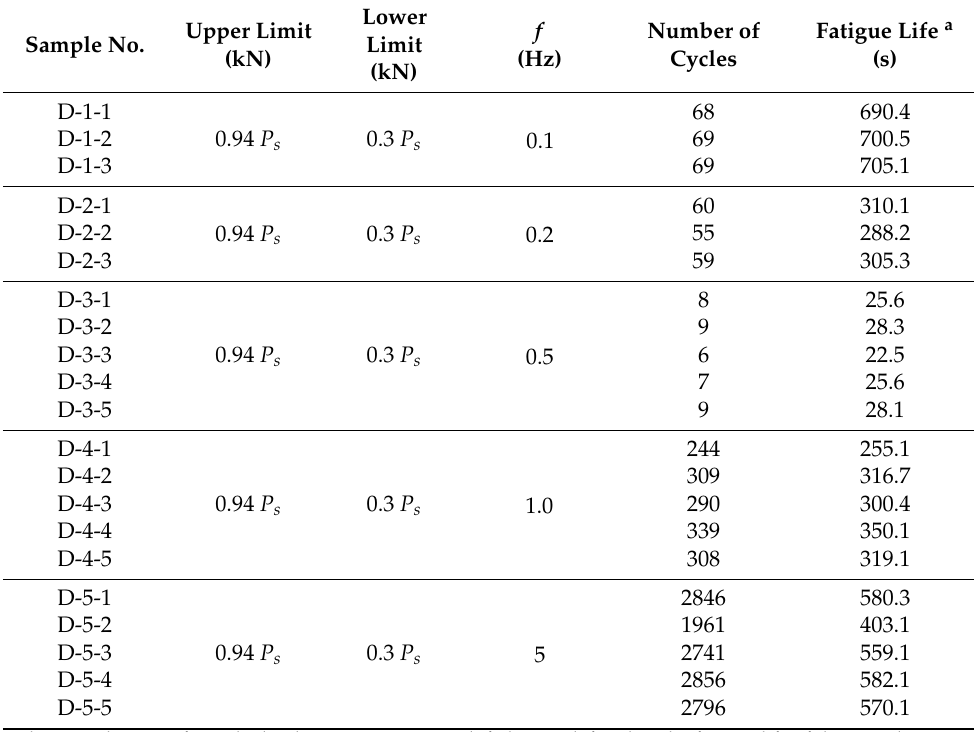
Table 1. Test parameters and results in CPL testing with different loading frequencies.